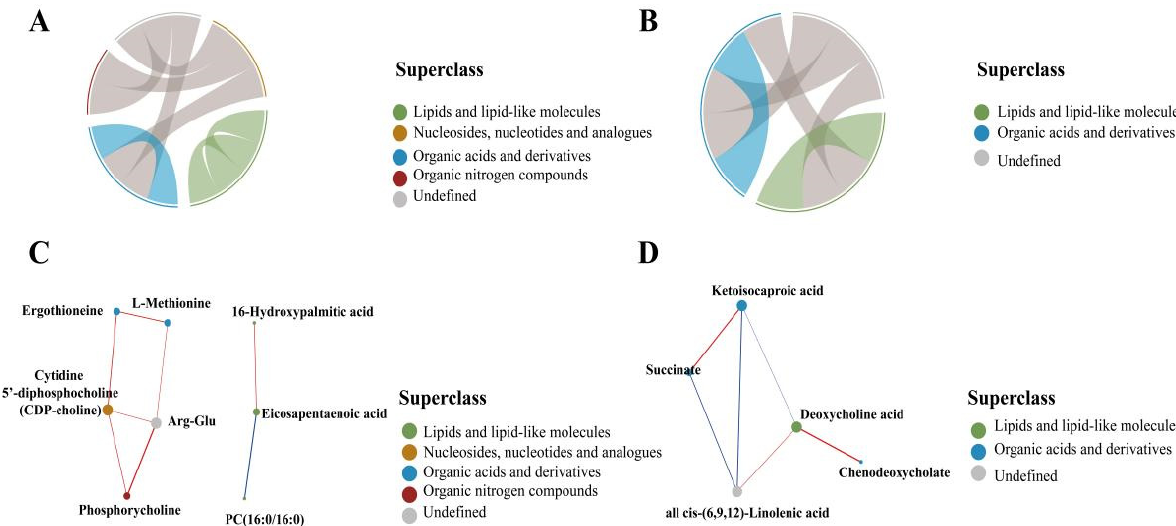
Figure 5. Chord diagram and network diagram for positive ion mode and negative ion mode. ( A ) Positive ion mode chord diagram. ( B ) Negative ion mode chord diagram. The starting point of the link in the inner circle in the Figure represents each significantly different metabolite, and the arc on the outer circle represents the classification of the significantly different metabolite. Colored lines indicate correlations within the various metabolites, and the lines are the same color as the subclasses. Dark grey lines indicate correlations between different classes of metabolites. ( C ) Positive ion mode network diagram. ( D ) Negative ion mode network diagram. The dots in the Figure represent significantly different metabolites. The size of the dots is related to the degree of connectivity. The greater the degree, the larger the dot. The colors of the lines represent correlations, red for positive correlations and blue for negative correlations. The thickness of the line represents the absolute value of the correlation coefficient. The thicker the line, the greater the correlation.